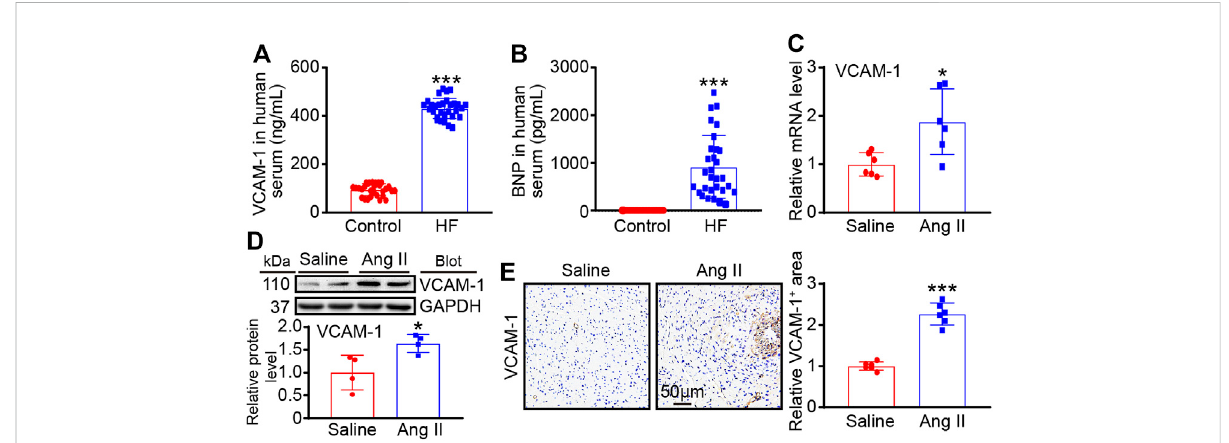
FIGURE 1 VCAM-1 is upregulated in HFpatients and AngII-infused mice. (A) Analysis ofserum VCAM-1 levels in HF patients and control subjects byELISA ( n = 30) (B) Analysis of serum BNP levels in HF patients and control subjects by ELISA ( n = 30) (C) WT mice were infused with saline or Ang II (1,000 ng/kg/min)for14daysqPCRanalysisofVCAM-1mRNAlevelsinhearttissues( n =6) (D) ImmunoblotanalysisofVCAM-1proteinlevelsinheart tissues (top) and quanti fi cation of relative protein levels (bottom, n = 4) (E) Immunohistochemical staining of VCAM-1 in heart sections